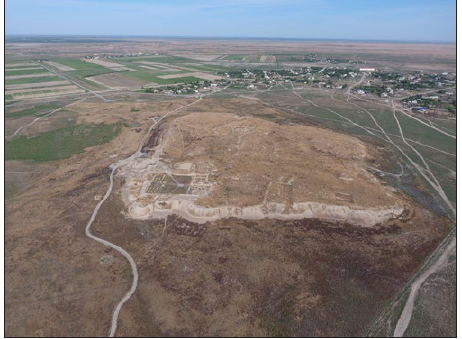
Figure 4: The medieval city of Otrar oasis, Kazakhstan (Photo: Gaigysyz